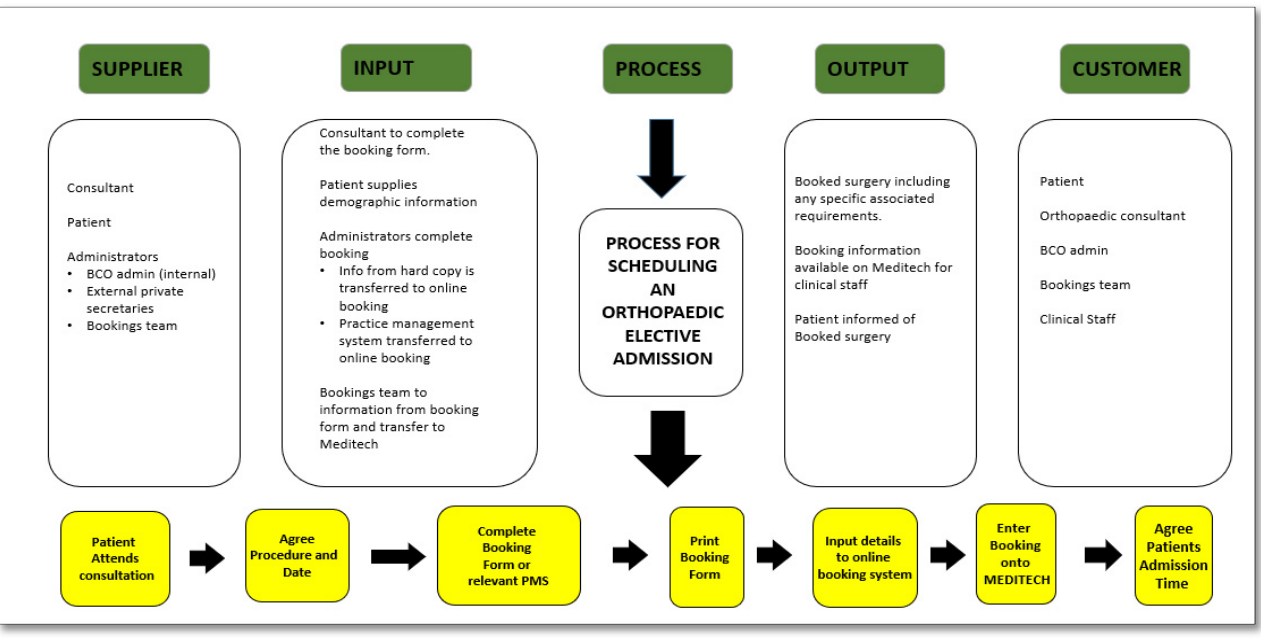
Figure 2. SIPOC. Figure 2.